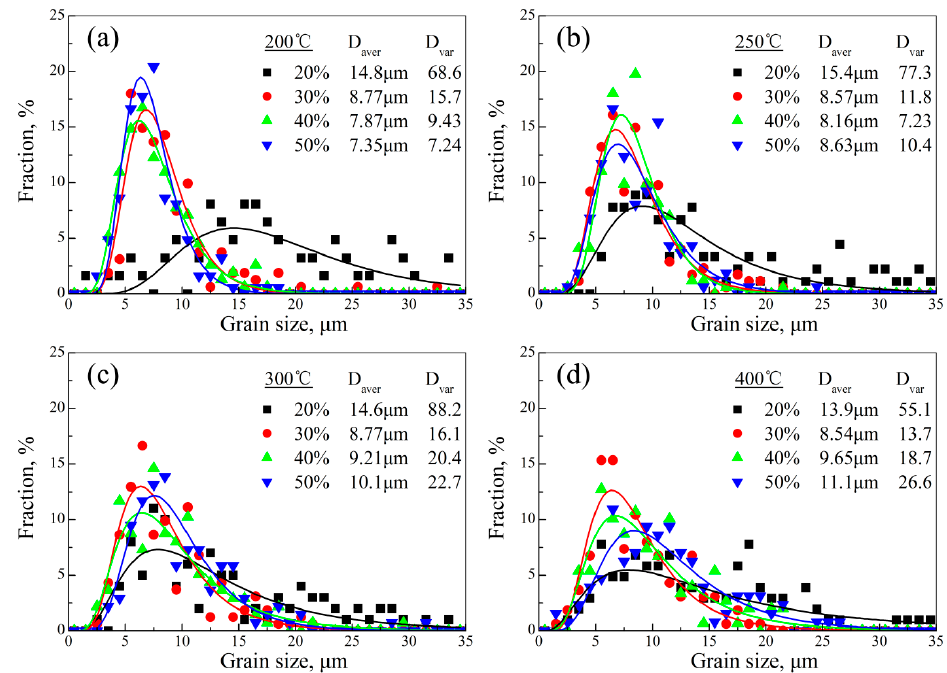
Figure 3. Grain size distributions of AZ31 magnesium alloy sheets under different rolling process parameters: ( a ) 200 ◦ C, ( b ) 250 ◦ C, ( c ) 300 ◦ C, and ( d ) 400 ◦